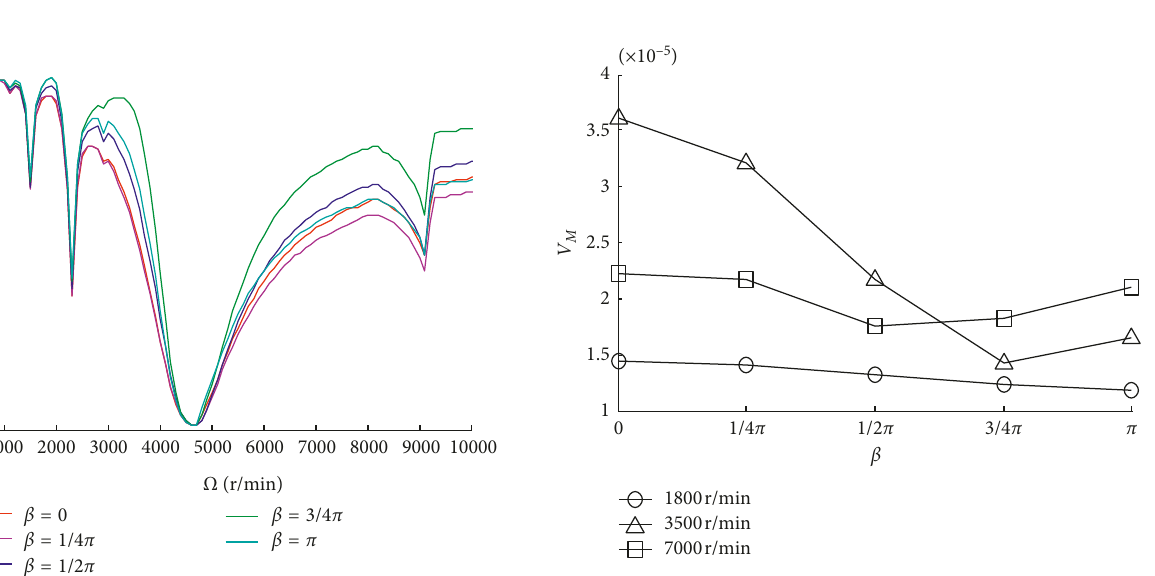
Figure 14: Fatigue degradation life versus rotation speed for various unbalance orientation angles with ε � 1 × 10 − 5 m and ζ � 0.01.